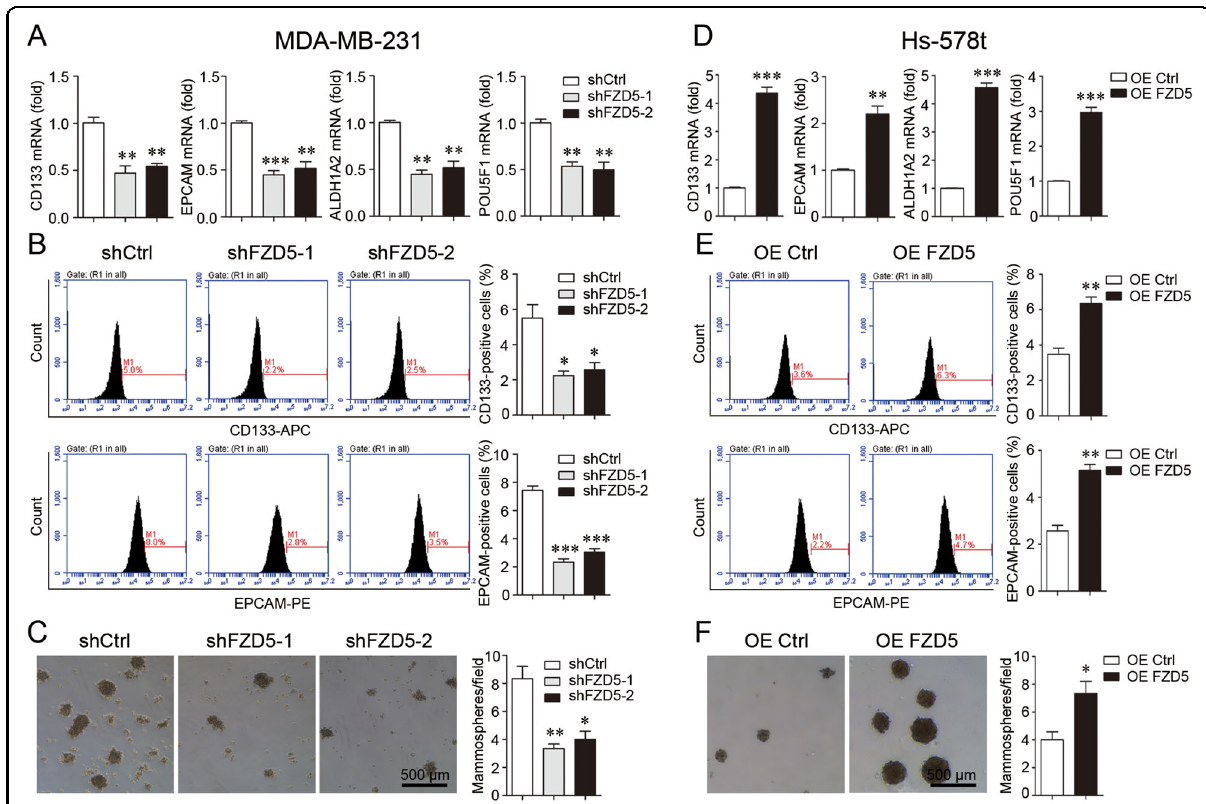
Fig. 5 FZD5 maintains stem cell-like properties. A CD133, EPCAM, ALDH1A2, and POU5F1 expression in MDA-MB-231 cells was detected by real- time PCR. B Fractions of CD133-positive and EPCAM-positive MDA-MB-231 cells were detected by fl ow cytometry. C Mammosphere formation of MDA-MB-231 cells was shown. Scale bar: 500 μ m, mean ± SD, n = 3. * P < 0.05, ** P < 0.01, *** P < 0.001, vs. shCtrl. D CD133, EPCAM, ALDH1A2, and POU5F1 expression in Hs-578t cells was detected by real-time PCR. E Fractions of CD133-positive and E PCAM-positive Hs-578t cells were detected by fl ow cytometry. F Mammosphere formation of Hs-578t cells was shown. Scale bar: 500 μ m, mean ± SD, n = 3. * P < 0.05, ** P < 0.01, *** P < 0.001, vs. OE